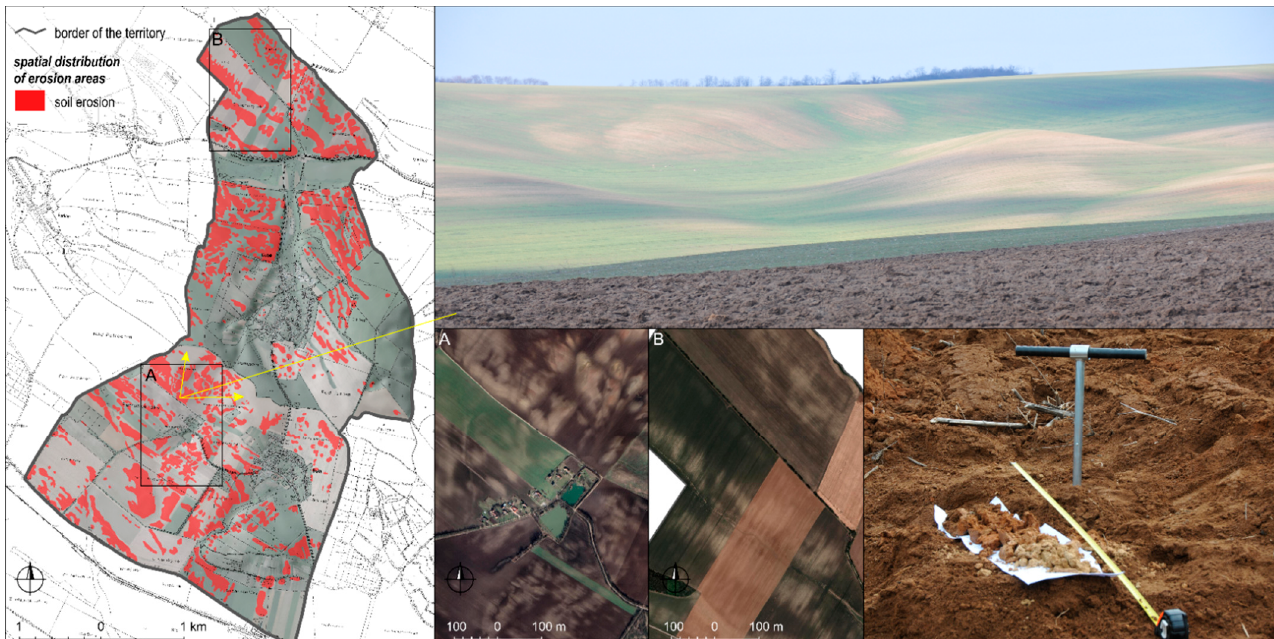
Figure 2. The color contrast is created by the loss of the dark humus horizon, which reveals the light yellow loess. The occurrence of these areas on aerial photos map is shown in ( A ) and ( B ). The figure on the left represents the digitized layer of these erosive areas. The bright (bleached) erosive areas have been verified by soil probes (the figure at the bottom right). By verification it was confirmed that all bleached areas are eroded.